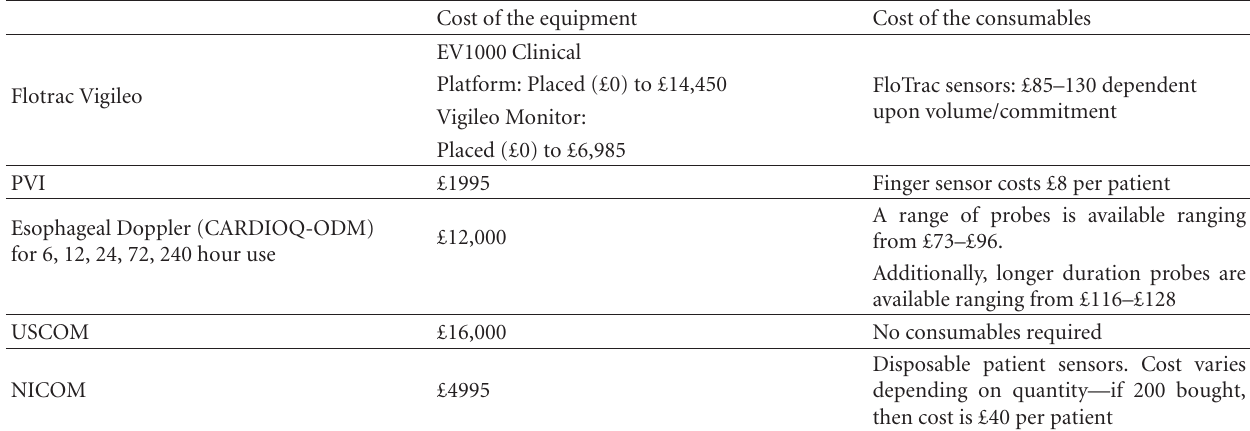
Table 6: Comparison of the cost of various technologies ∗